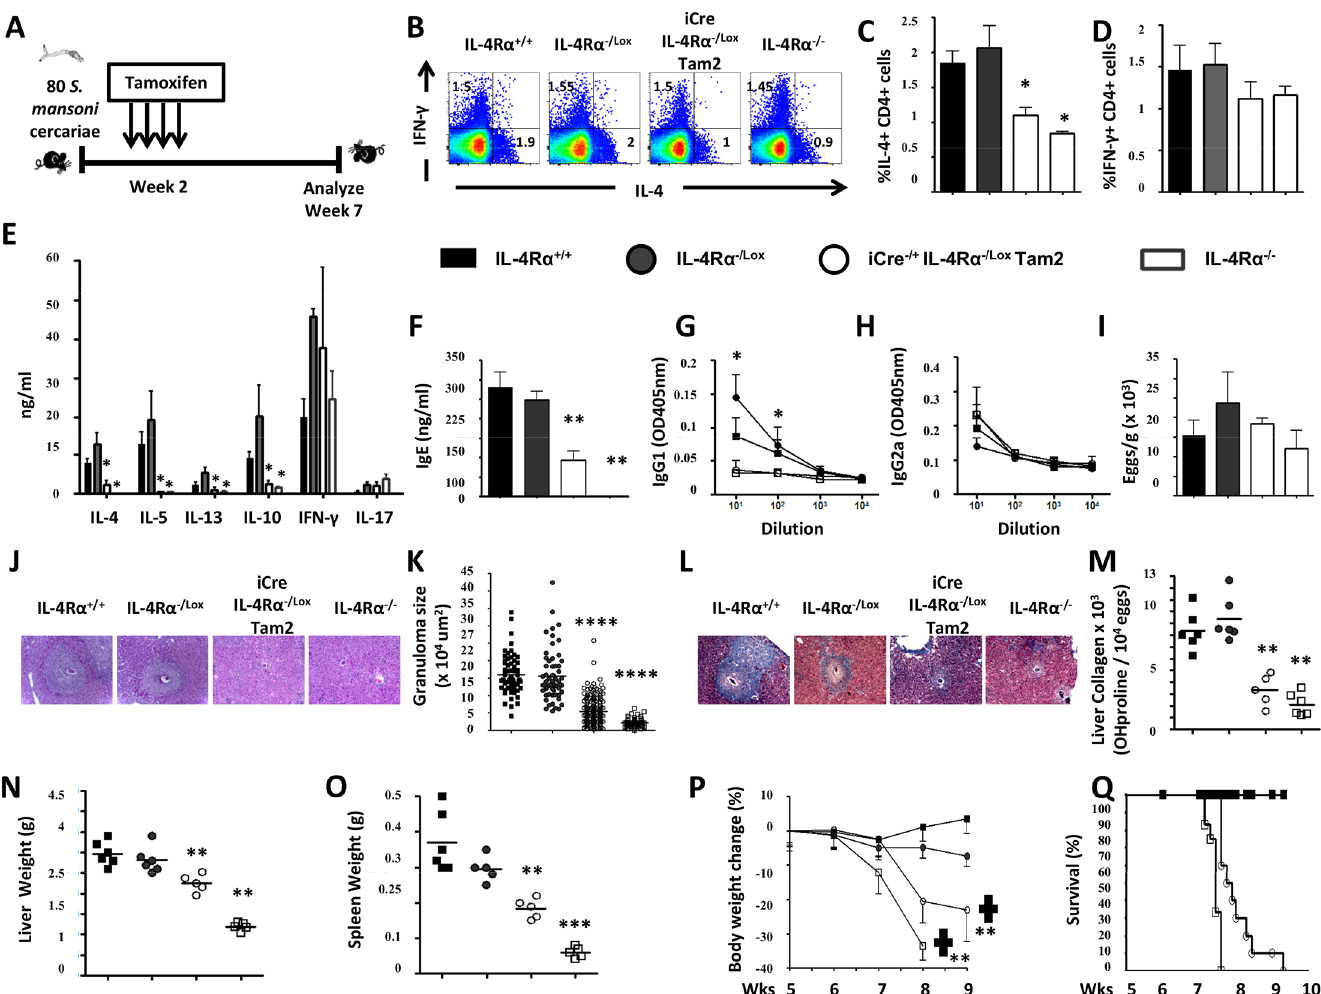
Fig 4. Immunological and histopathological profile of S . mansoni- infected mice after knocking down IL-4R α 2 weeks post-infection. A. Experimental design. B. Representative plot of MLN cytokine-producingCD3 + CD4 + T cell frequenciesafter stimulationwith PMA/Ionomycin/Monensin cocktail. Summariesof IL-4-producing ( C ) and IFN γ -producing( D ) CD3 + CD4 + T cell frequencies from 2 independent experiments conductedwith 3–8 mice are shown. E. Cytokinerelease detected by ELISA in the supernatant of anti-CD3stimulated MLN cells. F. Total seric IgE in S . mansoni -infected mice. SEA-specific seric IgG1 ( G ) and IgG2a ( H ) isotype antibodies. I. Liver Egg burden. J. Formalin-fixed Hematoxylin/Eosin-stained sectionsof liver tissue from infected animalsfor morphologicalanalyses(displayed here at 100X). K. Area sizes of egg-surroundinggranulomaare computed. L. Formalin- fixed CAB-stained sections of liver tissue from infected animalsfor collagendetection(displayed here at 100X). M. Hydroxyprolinecontent measuredby colorimetry is displayedas a measureof tissue collagencontent. Liver ( N ) and Spleen( O ) weights. P. Body weight changeover time following S . mansoni infection. Q. Survival curve following S . mansoni infection. Each experiment was conductedat least twice with 5–10 mice per group. Data are expressed as mean ± SD; NS = p > 0.05; * = p < 0.05; ** = p < 0.01; *** =, p < 0.001; **** = p < 0.0001.